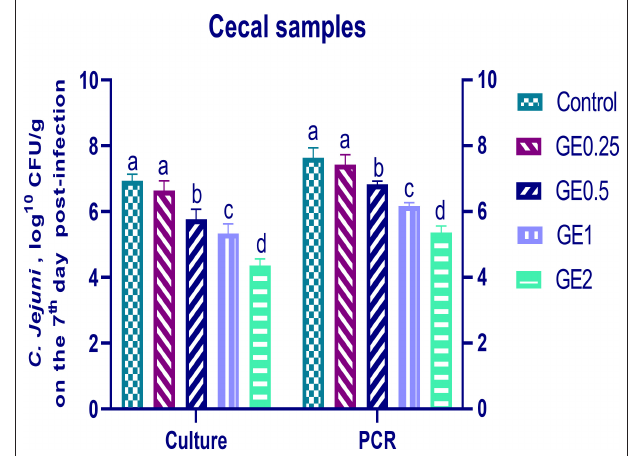
FIGURE 5 | Effects of dietary supplementation of Glycyrrhiza extract on C. jejuni population in cecal samples 7 days post-infection (Culture and RT-qPCR). Control referred to basal diet. GE0.25, GE0.5, GE1, and GE2 referred to basal diet supplemented with 0.25, 0.5, 1, and 2 g/kg Glycyrrhiza extract, respectively. Data represent mean values from 10 independent experiments, error bars indicate SE, n = per 20. C. jejuni count was significantly decreased in all groups supplemented with GE compared with the control group ( P < 0.05) except for GE0.25 showing non-significant difference ( P <